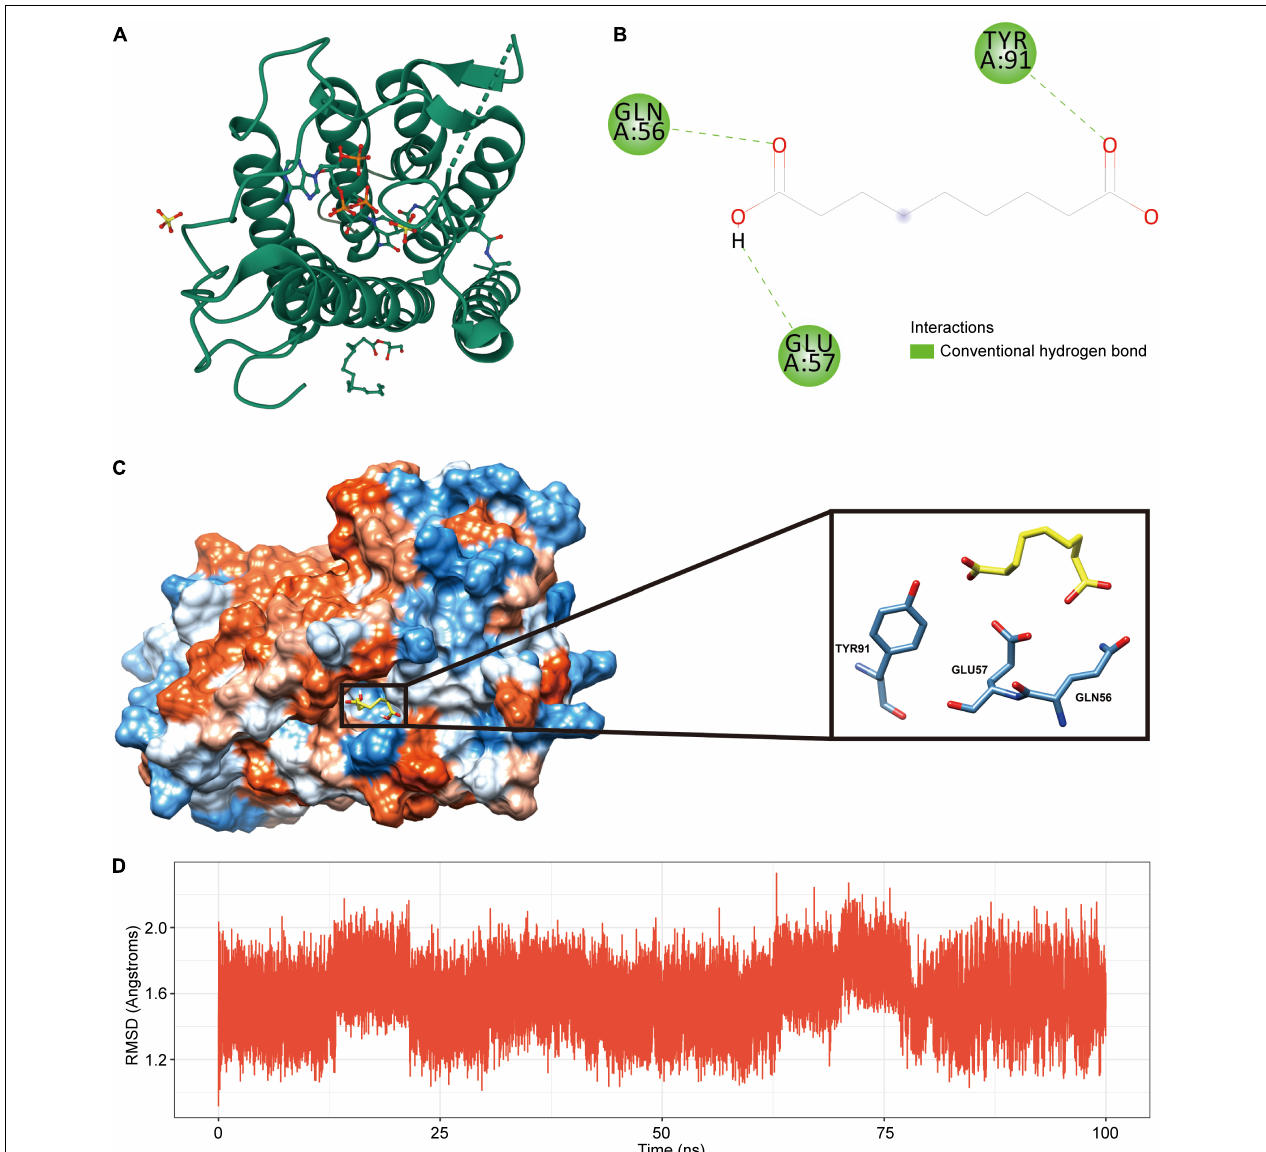
FIGURE 6 | SRD5A2- Azelaic acid molecular docking analysis. (A) 3D model of SRD5A2 protein structure. (B) 2D interaction diagram of Azelaic acid and SRD5A2 protein. (C) The binding domain of Azelaic acid and SRD5A2 protein, in which hydrogen bonds are shown in green and hydrophobic interactions are shown in pink. Amino acid residues are displayed as steel blue. (D) The curve of the RMSD value of the protein backbone during molecular dynamics in